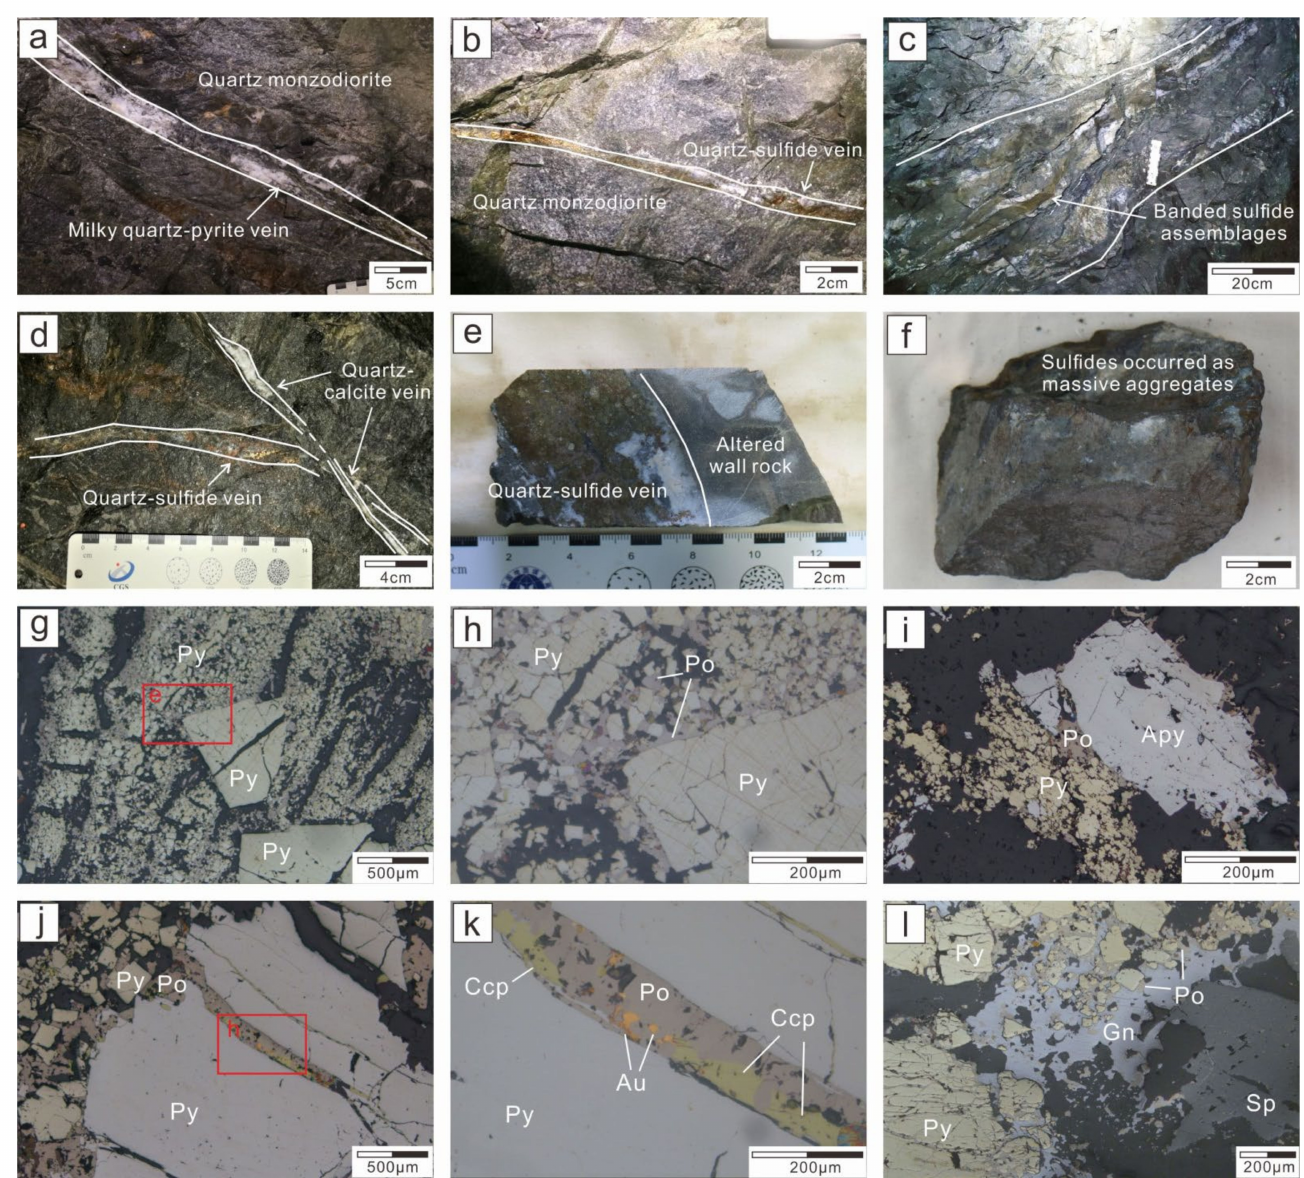
Figure 3. Typical alteration and mineralization in the Sanakham gold deposit ( d – i are reflected light images). ( a ), Milky quartz–pyrite vein in quartz monzodiorite; ( b ), quartz–sulfide vein in quartz monzodiorite; ( c ), banded sulfide assemblages; ( d ), quartz—calcite vein crosscut quartz—sulfide vein; ( e ), coexistence of sulfides and quartz in hand sample; ( f ), sulfides occurred as massive aggregates; ( g , h ), stage I euhedral to subhedral coarse-grained pyrite and stage II subhedral to anhedral fine- grained pyrite and pyrrhotite; ( i ), stage II pyrite and pyrrhotite occurred around stage I arsenopyrite; ( j , k ), native gold coexisting with pyrrhotite or chalcopyrite that fills in fractures of pyrite; ( l ), sulfide aggregations in stage III. Apy, arsenopyrite; Au, native gold; Ccp, chalcopyrite; Gn, galena; Po, pyrrhotite; Py,